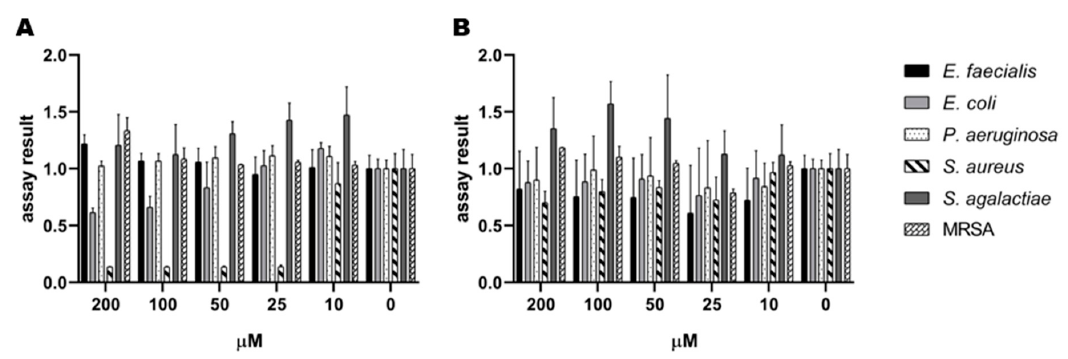
Figure 7. Initial screen of antibacterial activity of ( A ) serratiochelin A ( 1 ) and ( B ) serratiochelin C ( 2 ) on E. faecialis , E. coli , P. aeruginosa , S. agalactiae , and MRSA, normalized assay results. The experiment was executed twice with two technical replicates each.